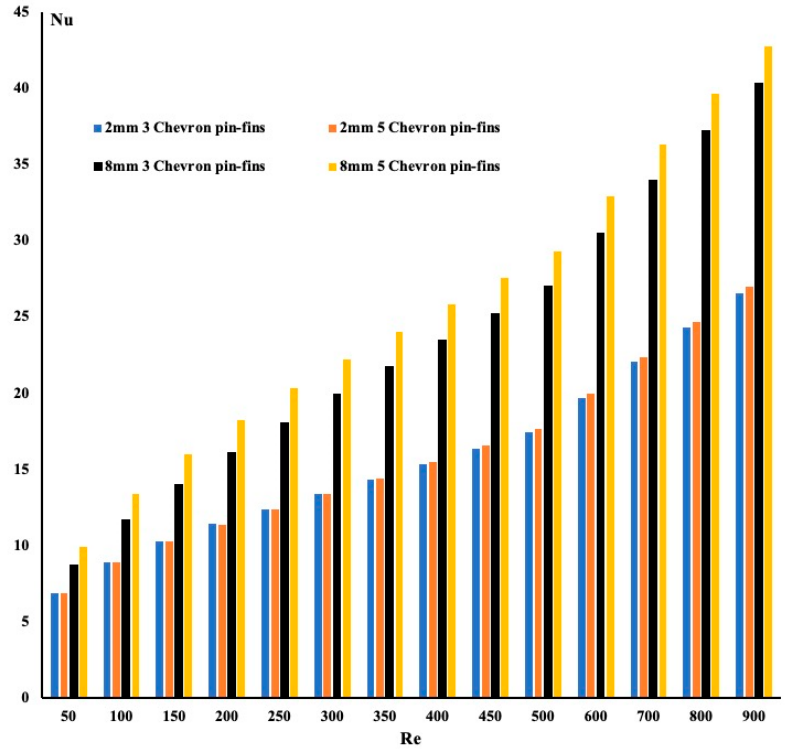
Figure 4. Nusselt number variation for solid pin-fins.